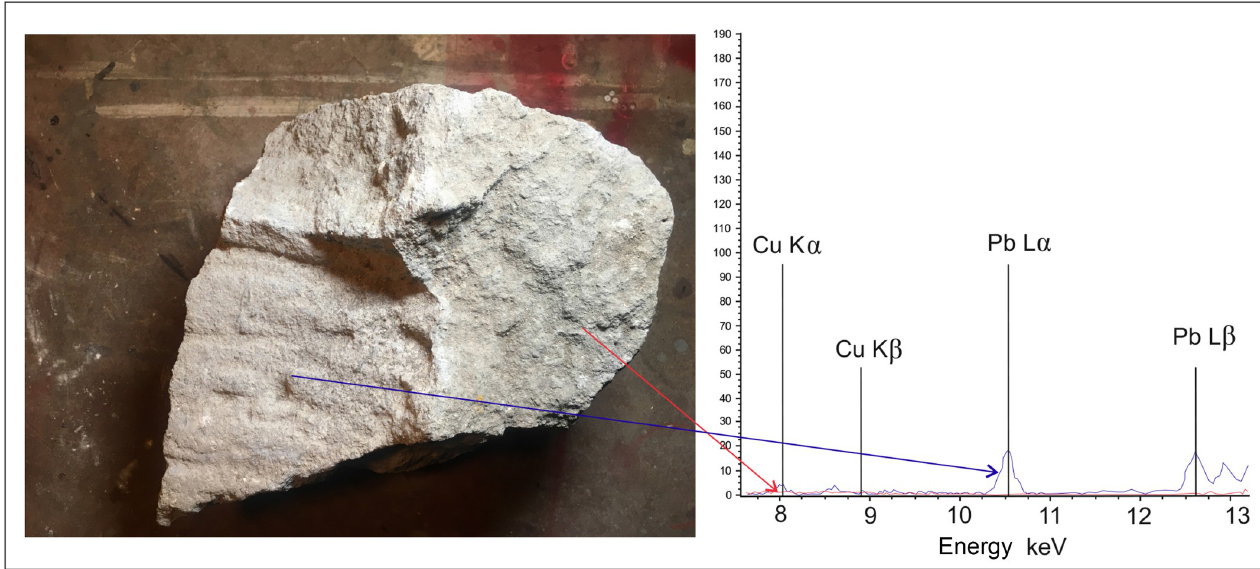
Fig 7. XRF measurement of the sample of the historic surface from the 4th century BC (interior of one of the tombs in the necropolis of Morre, Tarquinia). 1 non worked surface (red line), 2 worked up surface by the axe (grey line). The worked up surface shows a significant increase of the amounts of the copper and lead (photo and graph: M. Cihla).